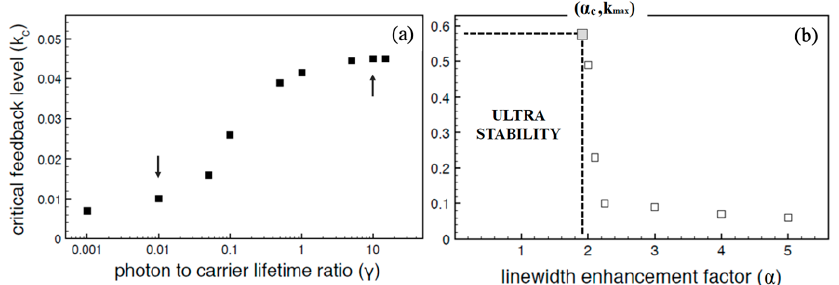
Figure 6. Dependence of the lowest feedback level κ c necessary for triggering mode instability on the laser stationary emission on the lifetime ratio ( a ) and the linewidth enhancement factor (LEF) ( b ). Downward arrow in ( a ) marks typical value of semiconductor diode lasers, whereas upward arrow marks values of quantum-cascade lasers. ( b ) for γ = 10, the stationary solution remains stable irrespective of the feedback level at LEF values smaller than about 2 (adapted from Reference [28]).